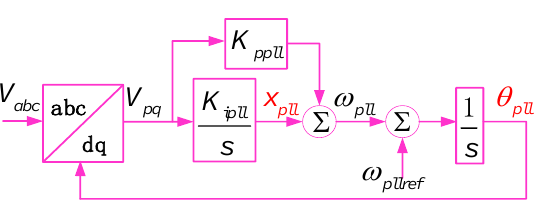
Figure 4. Block diagram of the synchronous reference frame phase-locked loop (SRF-PLL).